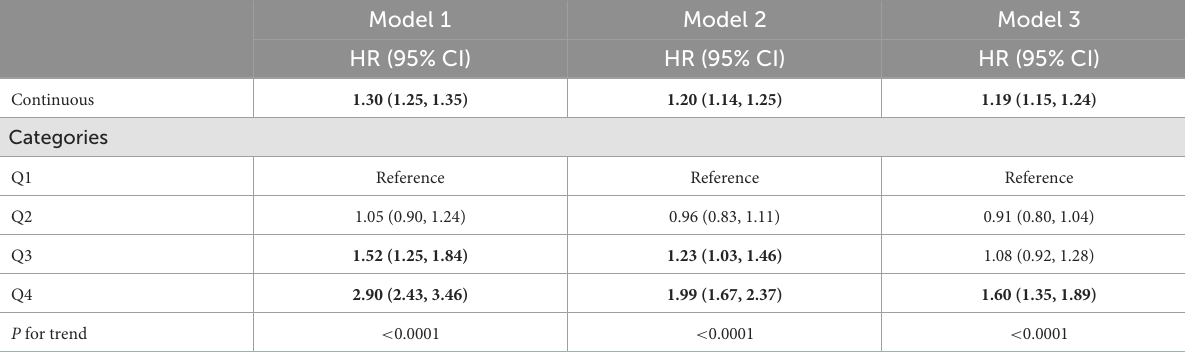
TABLE 3 Risk of CVD mortality among hypertension patients according to